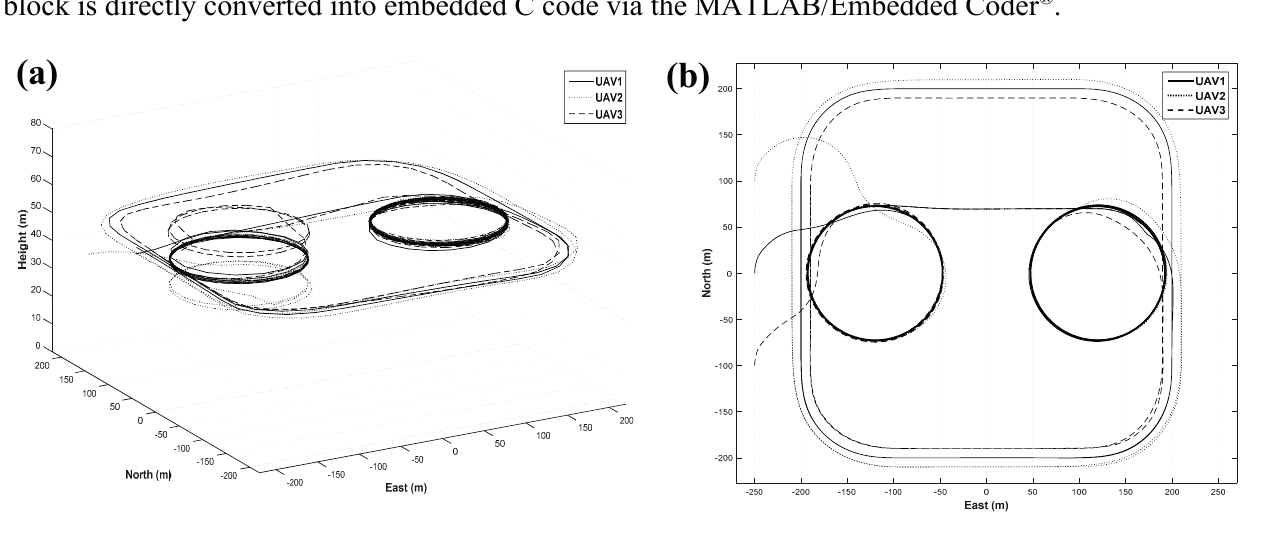
Figure 14. ( a ) 3D; and ( b ) 2D simulation results of integrated formation